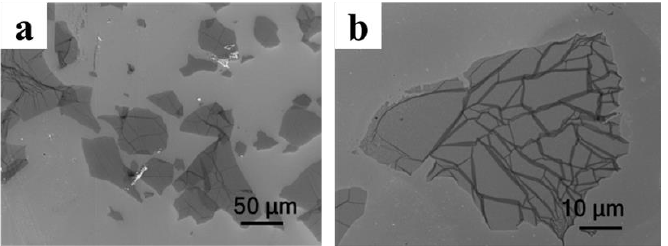
Figure 2. SEM image of LGO. ( a ) SEM image with 50 μ m scale; ( b ) SEM image with 10 μ m scale.